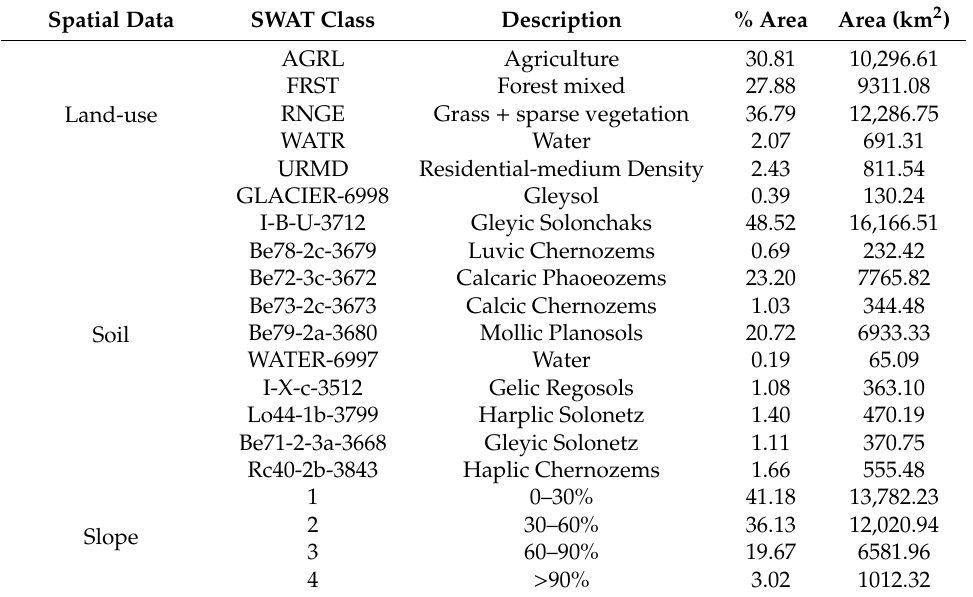
Figure 2. ( a ) Land-use and ( b ) Soil map of the study area. Table 3. Land-use, soil, and slope report.